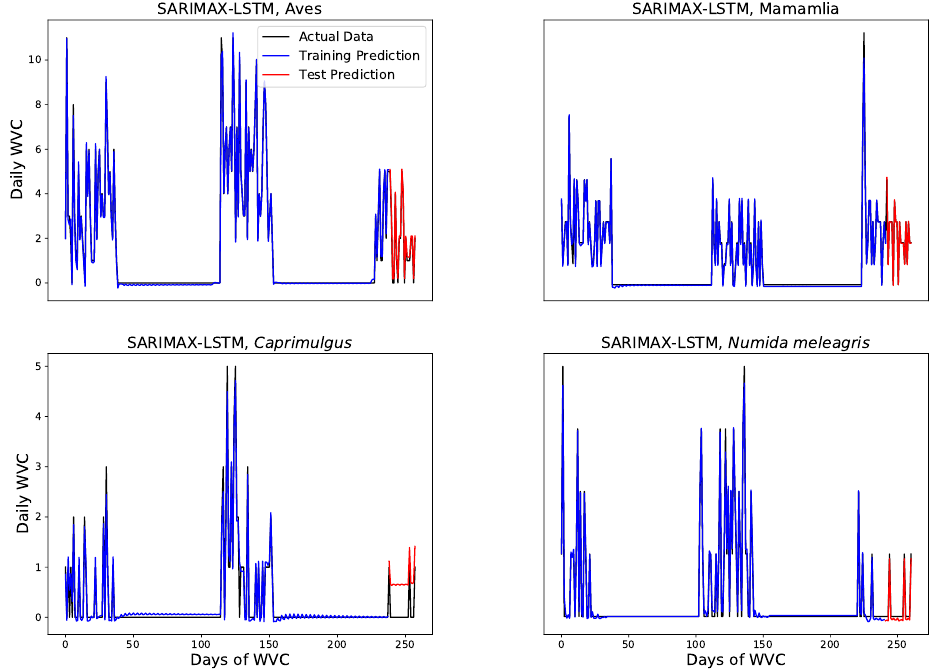
Figure 12. A time series of daily wildlife roadkill showing actual data and predicted data using SARIMAX-LSTM on the Aves (top-left panel), Mammalia (top-right panel), Caprimulgus (bottom-left panel), and Numida meleagris (bottom-right panel)